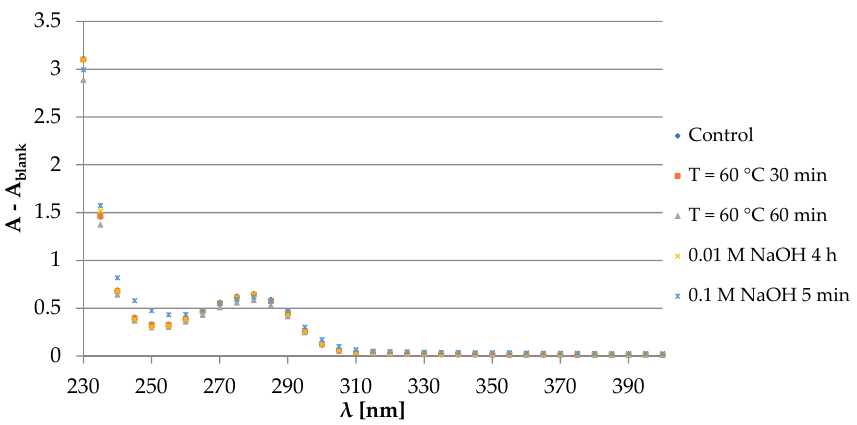
Figure A9. SEC-HPLC chromatograms of Lf samples (optimized SEC-HPLC method on an XBridge ® Protein BEH SEC 200 Ǻ column): −− control sample (thermal), −− thermal stress sample (T = 60 °C, t = 30 min), −− control sample (acidic and alkaline), −− acidic stress sample (0.1 M HCl, t = 3 days), and −− alkaline stress sample (0.01 M NaOH, t = 4 h).